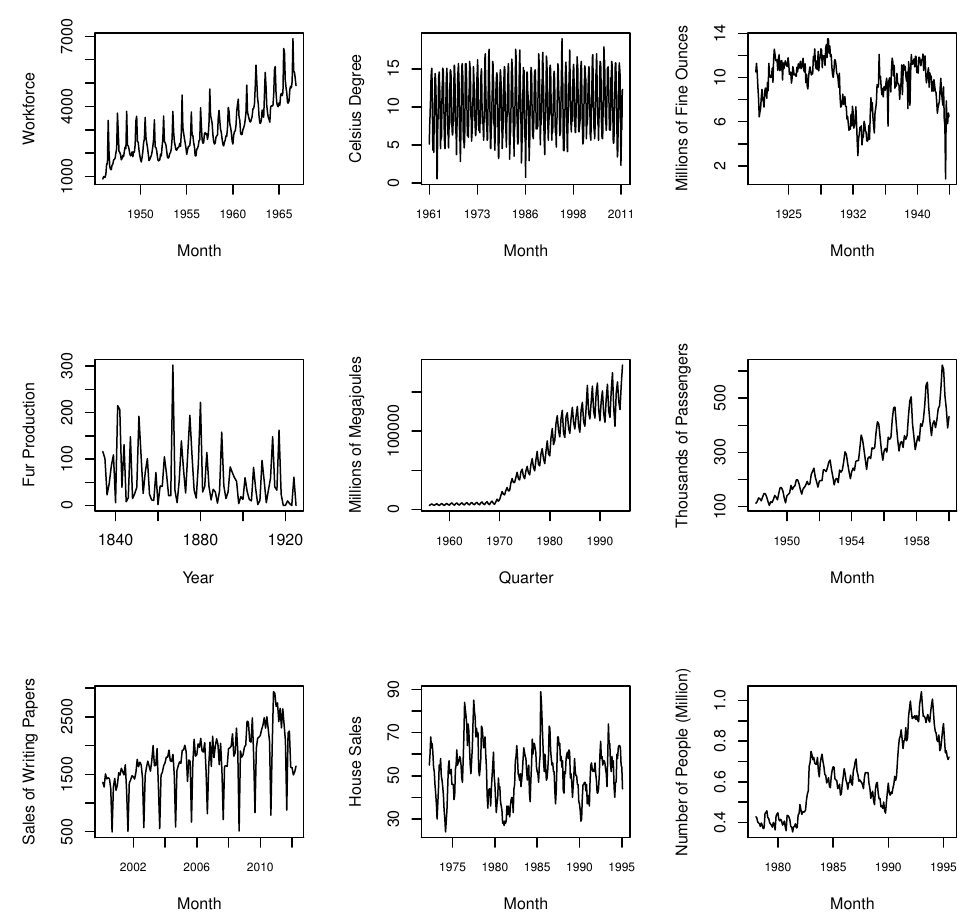
Figure 1. A selection of nine real time series. For each time series, the out-of-sample forecasting RMSE is calculated using both ba- sic SSA and SSA-GA, for very short, short, long and very long term forecasting horizons (i.e., h = 1, 3, 6, 12). To compare the RMSEs from two methods, we used the RRMSE defined as ratio of SSA-GA’s RMSE to basic SSA’s RMSE (i.e., RRMSE = RMSE SSA − GA / RMSE basicSSA